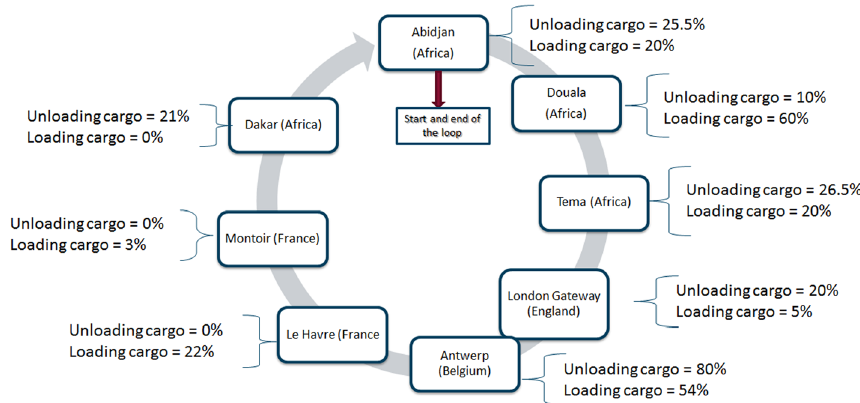
Fig. 5 Order of ports and (un)loading share (dry and reefer cargo)—scenario 1